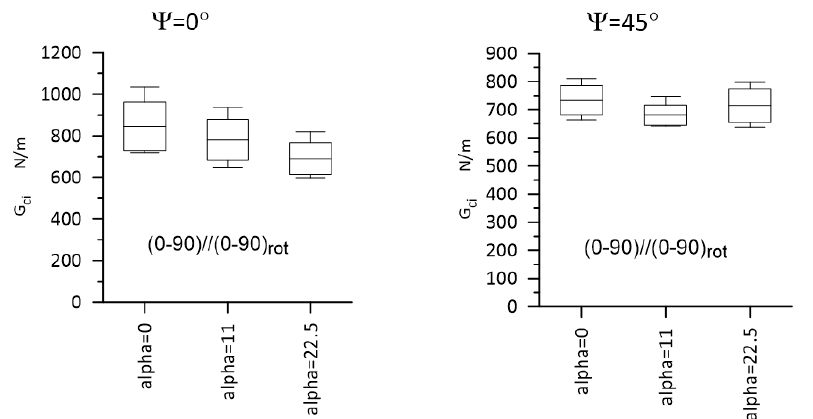
Figure 15. Gci values for Laminate B for Ψ = 0° and 45°. Statistically, a significant difference was detected for Ψ = 0°, for α = 0° vs. α = 22.5°. The whiskers limit the extreme values, the middle bars represent the mean values, and the boxes represent the standard deviations.